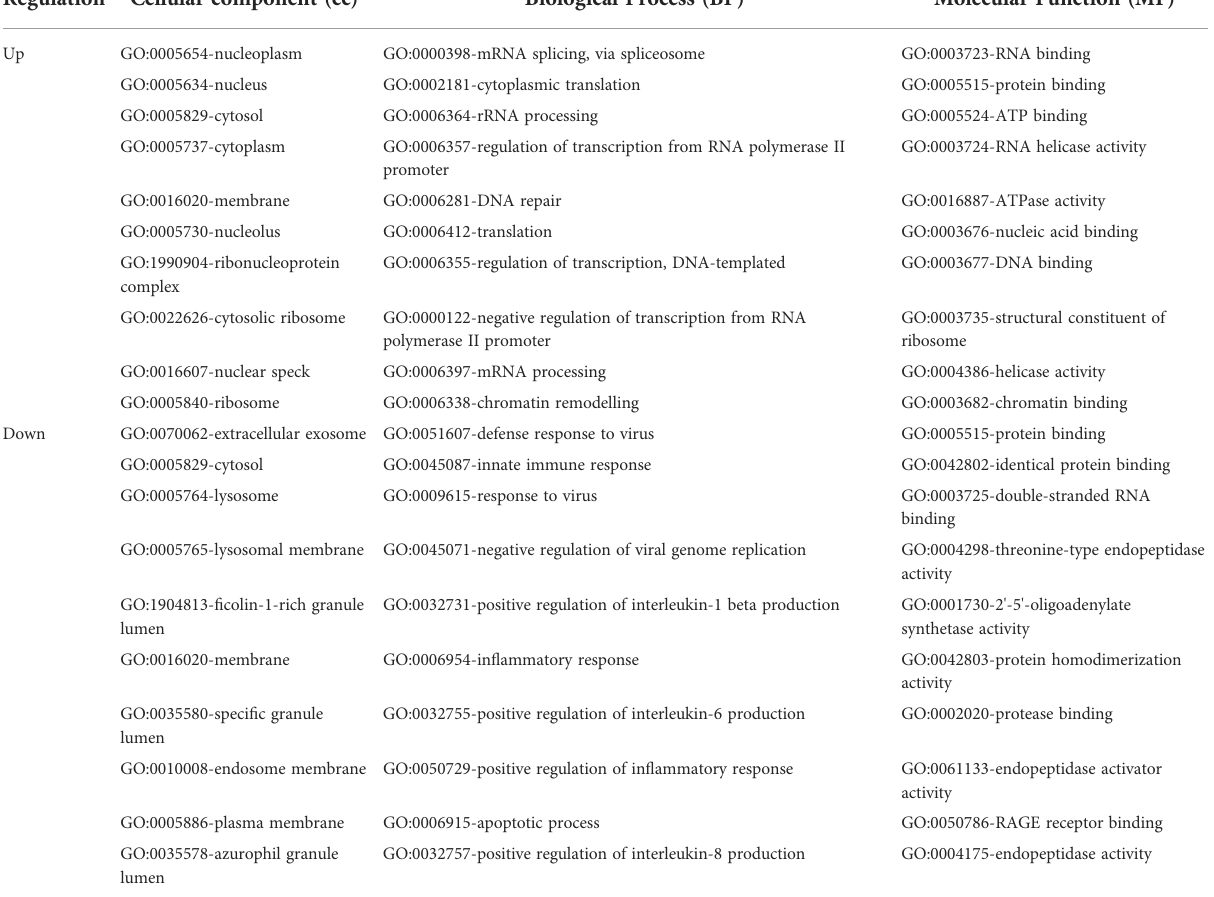
TABLE 3 Top 10 signi fi cantly enriched Gene ontologies. Regulation Cellular component (cc)